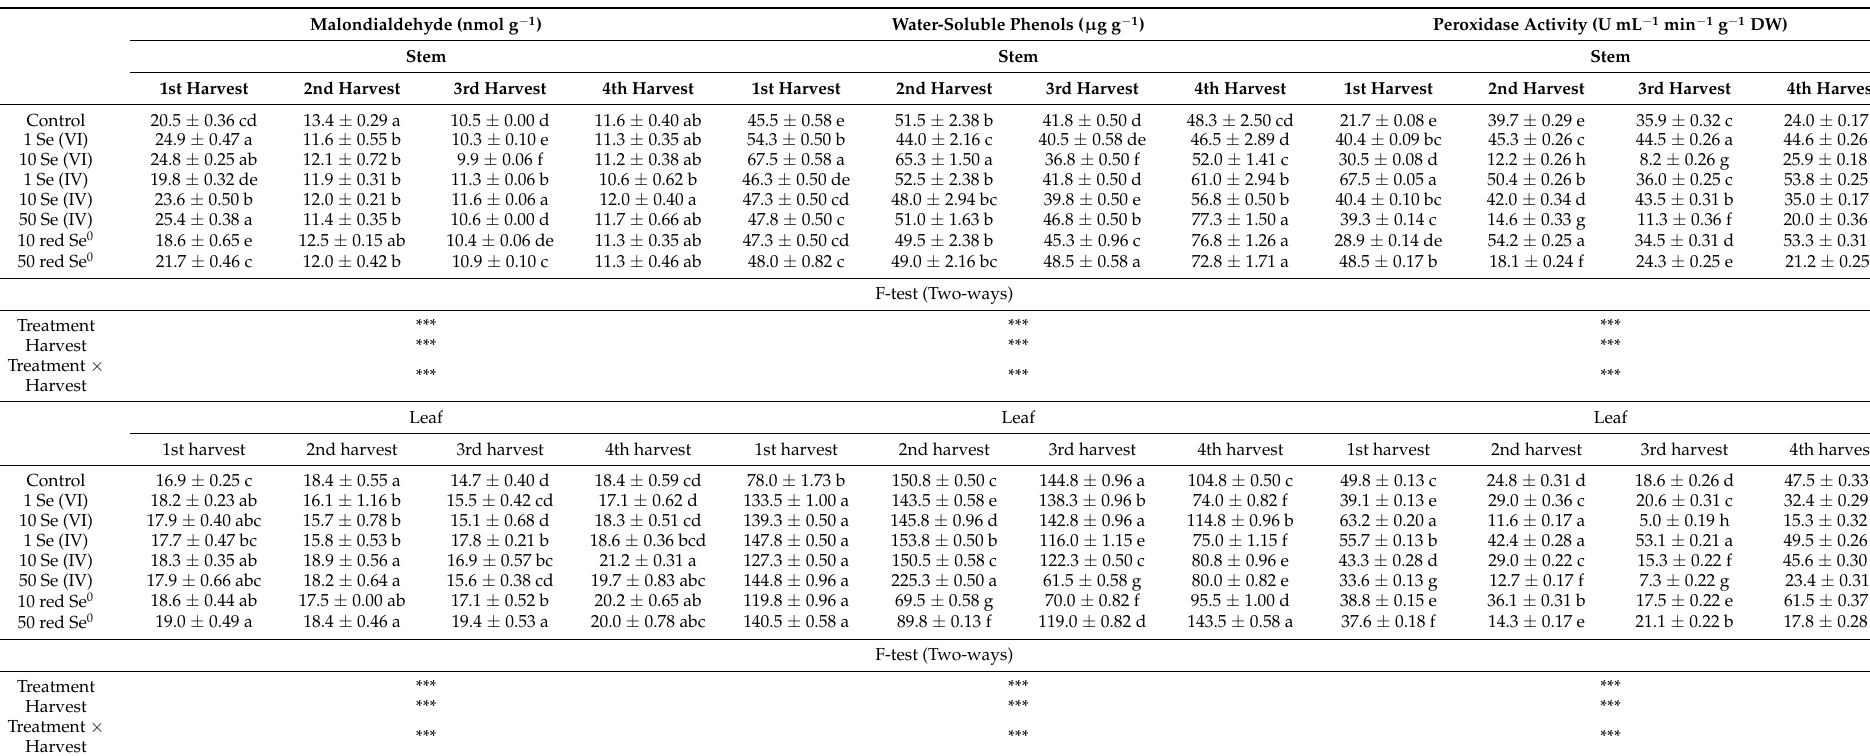
Table 2. Variations in some biochemical traits in alfalfa grown on different selenium (Se) forms (Se (VI), Se (IV), and red Se 0 ) and concentrations (1, 10, and 50 mg kg − 1 for ionic forms and 10 and 50 mg L − 1 for elemental form) during four consecutive